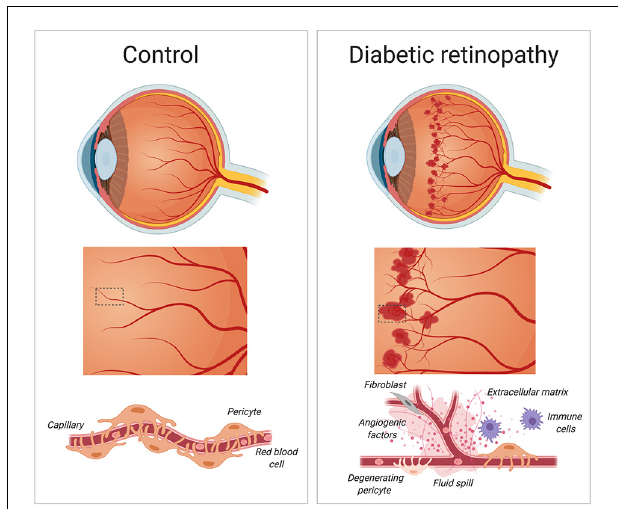
FIGURE 3 | Diabetic retinopathy. During the early stages of diabetic retinopathy, pericytes loss weakens blood capillaries in the retina, causing the formation of microaneurysms, fluid spill and bleeding into the macula. As diabetic retinopathy progresses, the growth of new and irregular blood vessels leads to the formation of a scar tissue that causes blurry vision and loss of eyesight. Created with biorender.com.